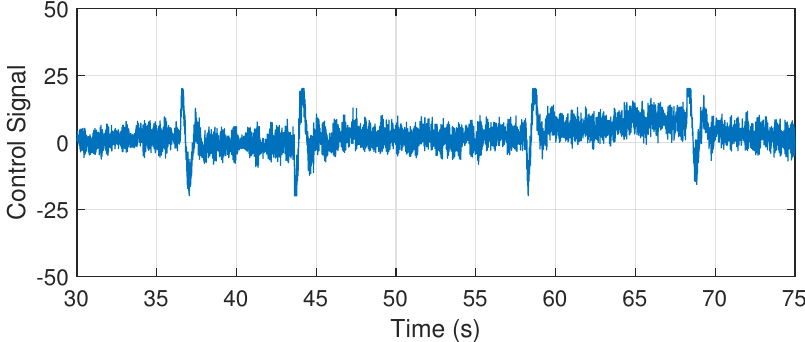
Figure 15. Control signal for roll axis tracking.